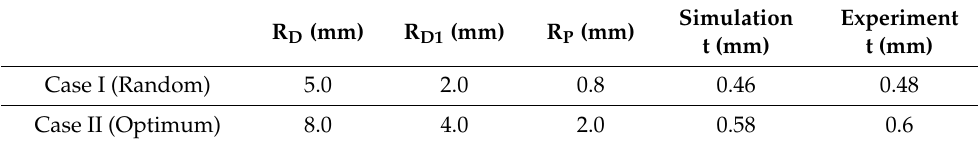
Table 8. The numerical and experimental thickness values of the camera cover